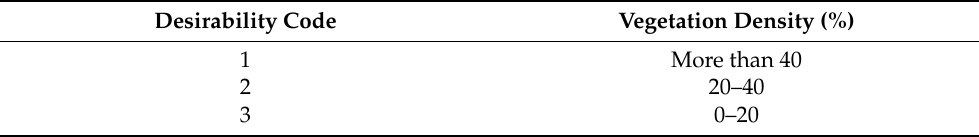
Table 4. Classification and coding of vegetation density